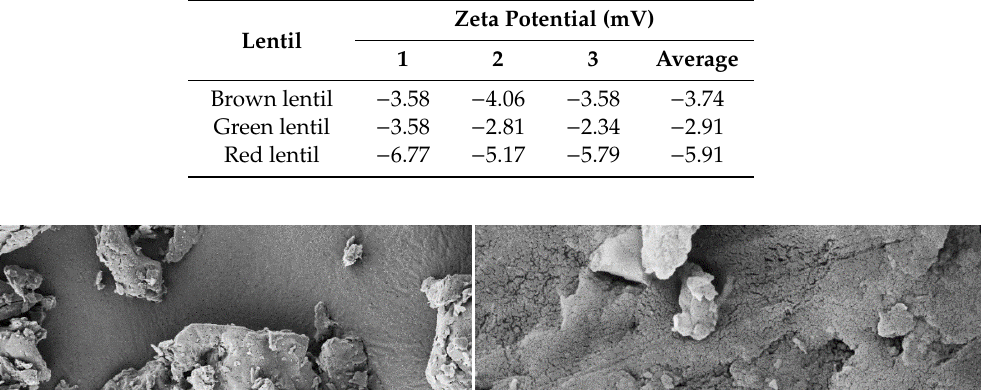
Table 3. Zeta potential of the lentil extracts.